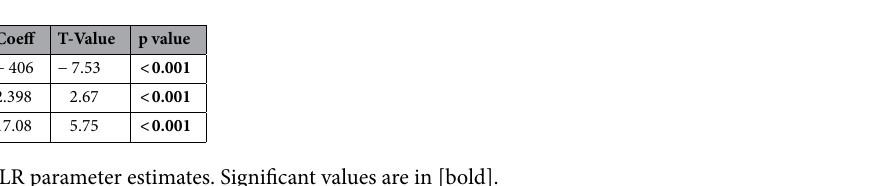
Table 2. MLR parameter estimates. Significant values are in